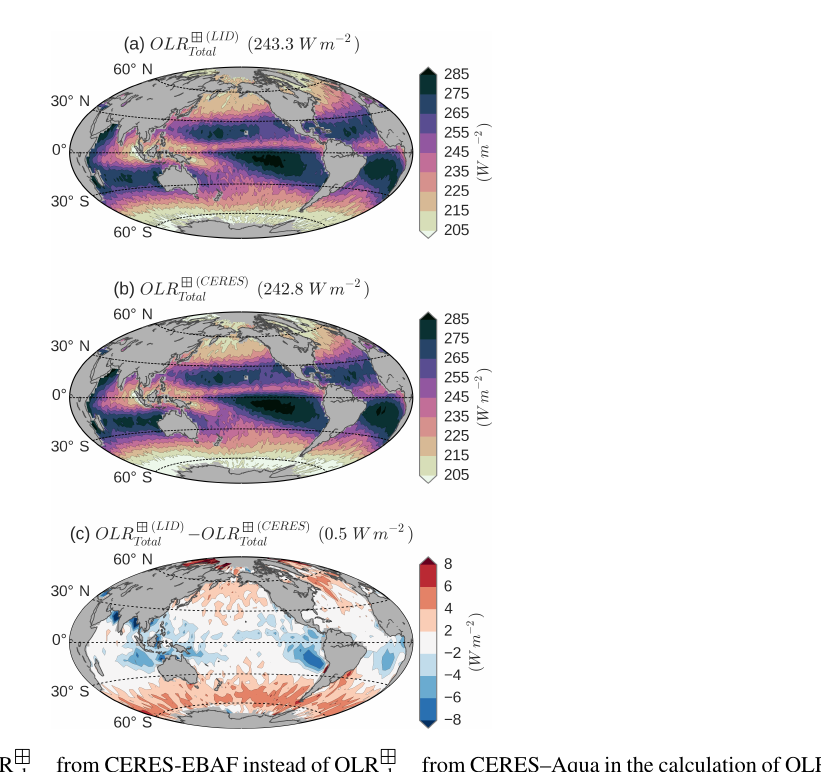
Figure E2. Same as Fig. 7 but using OLR